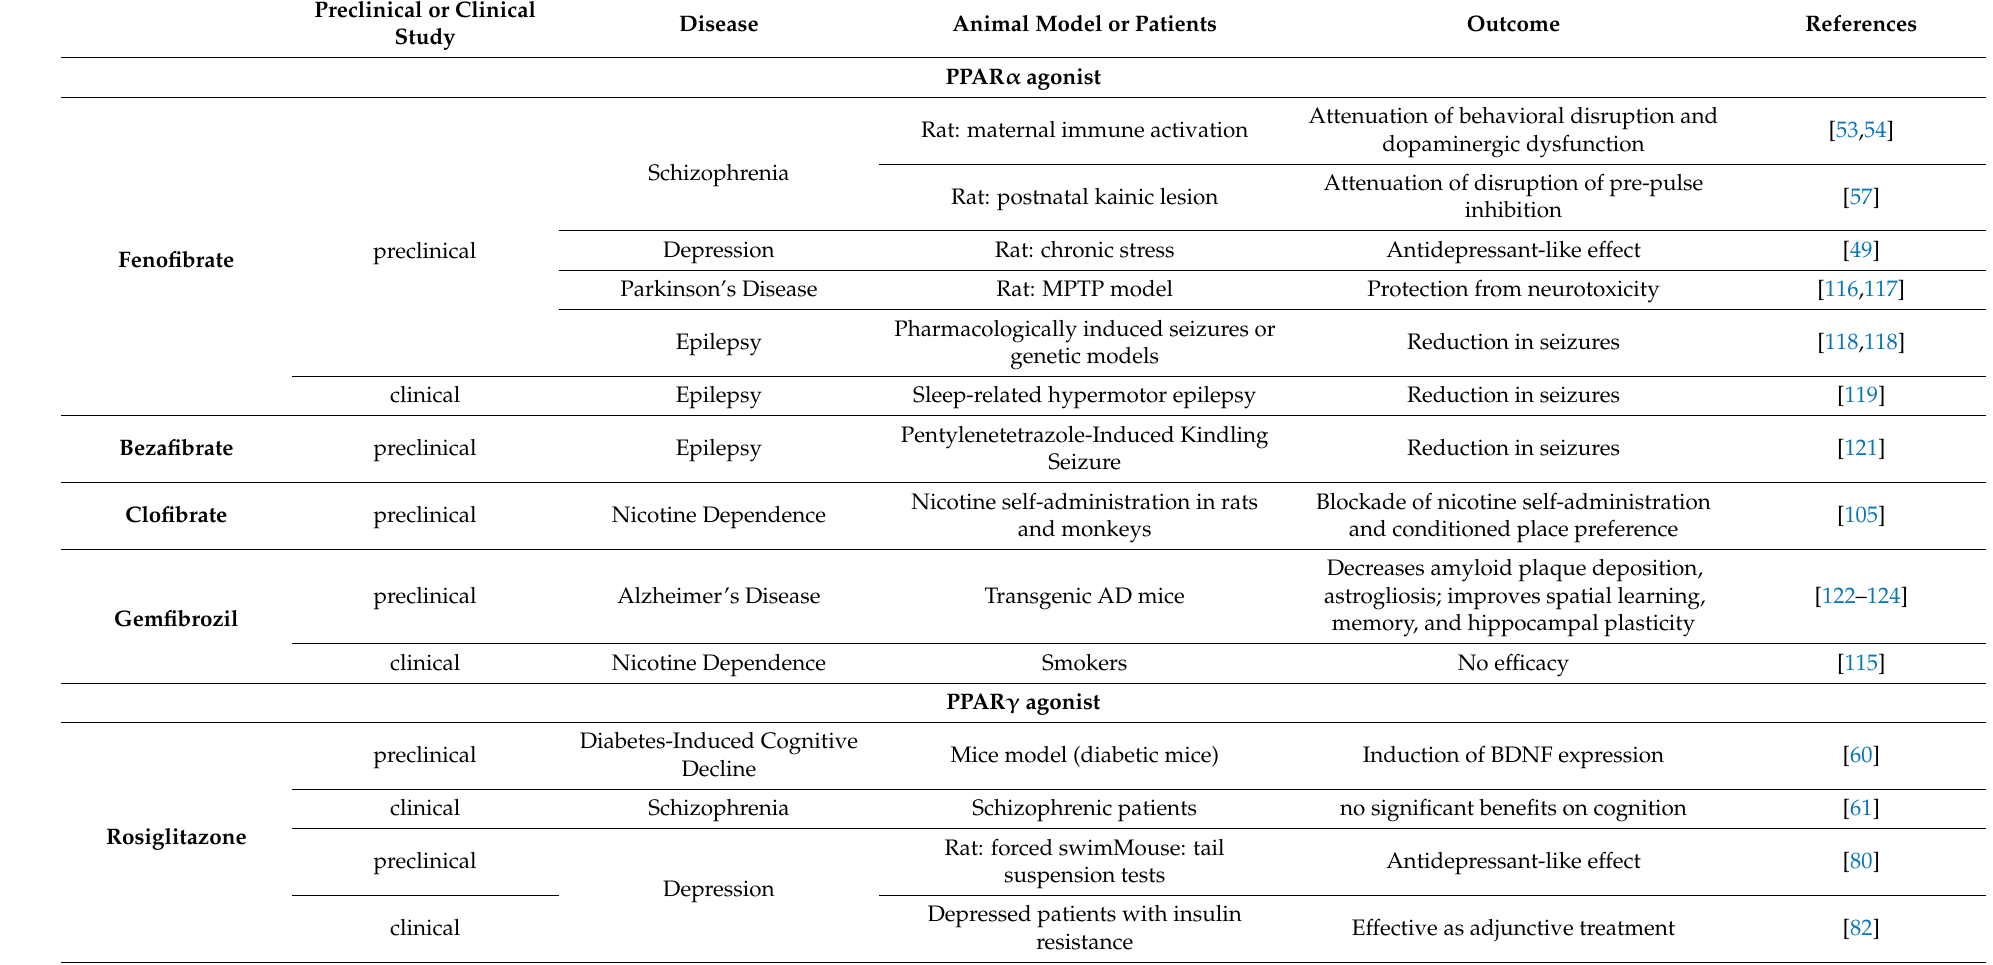
Table 1. This table summarizes the preclinical and clinical studies aiming to repurpose PPAR α and PAR γ agonists in psychiatric and neurological disorders. Further details can be found in the